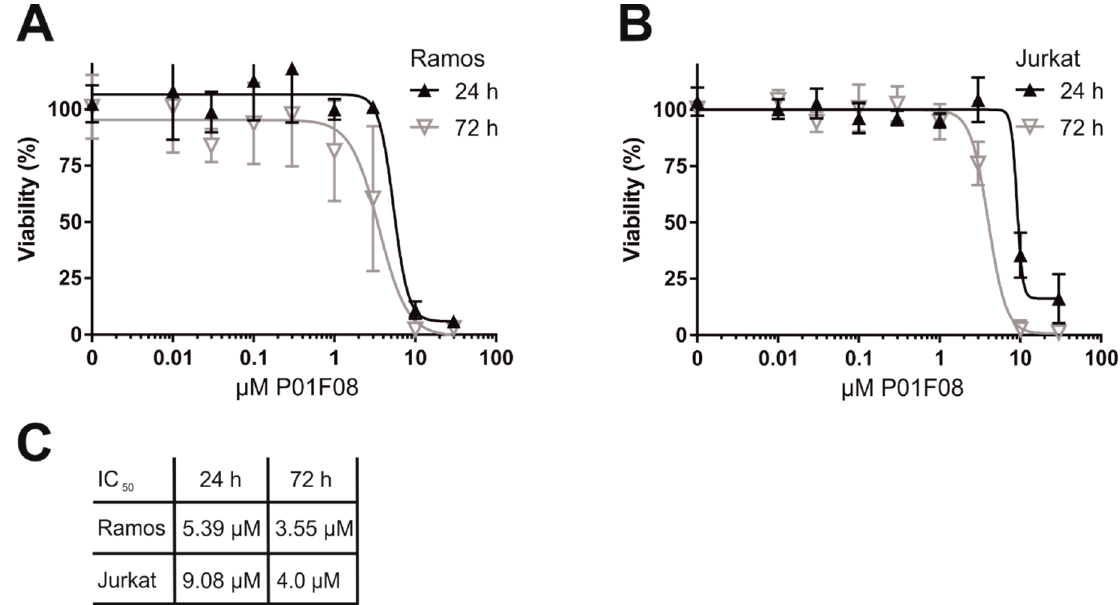
Figure 7. P01F08 acts highly cytotoxic in acute T cell leukemia (Jurkat) and Burkitt ′ s lymphoma B (Ramos) cells . Cytotoxicity in Ramos ( A ) or Jurkat ( B ) cells was determined after the indicated incubation periods using alamarblue viability assay. ( C ) Overview of the resulting IC 50 values in the individual cell lines at the respective incubation times. All experiments were performed in triplicates; the values were normalized to DMSO (0.1% v / v ; negative control). Error bars = SD of three independent experiments performed in triplicates.